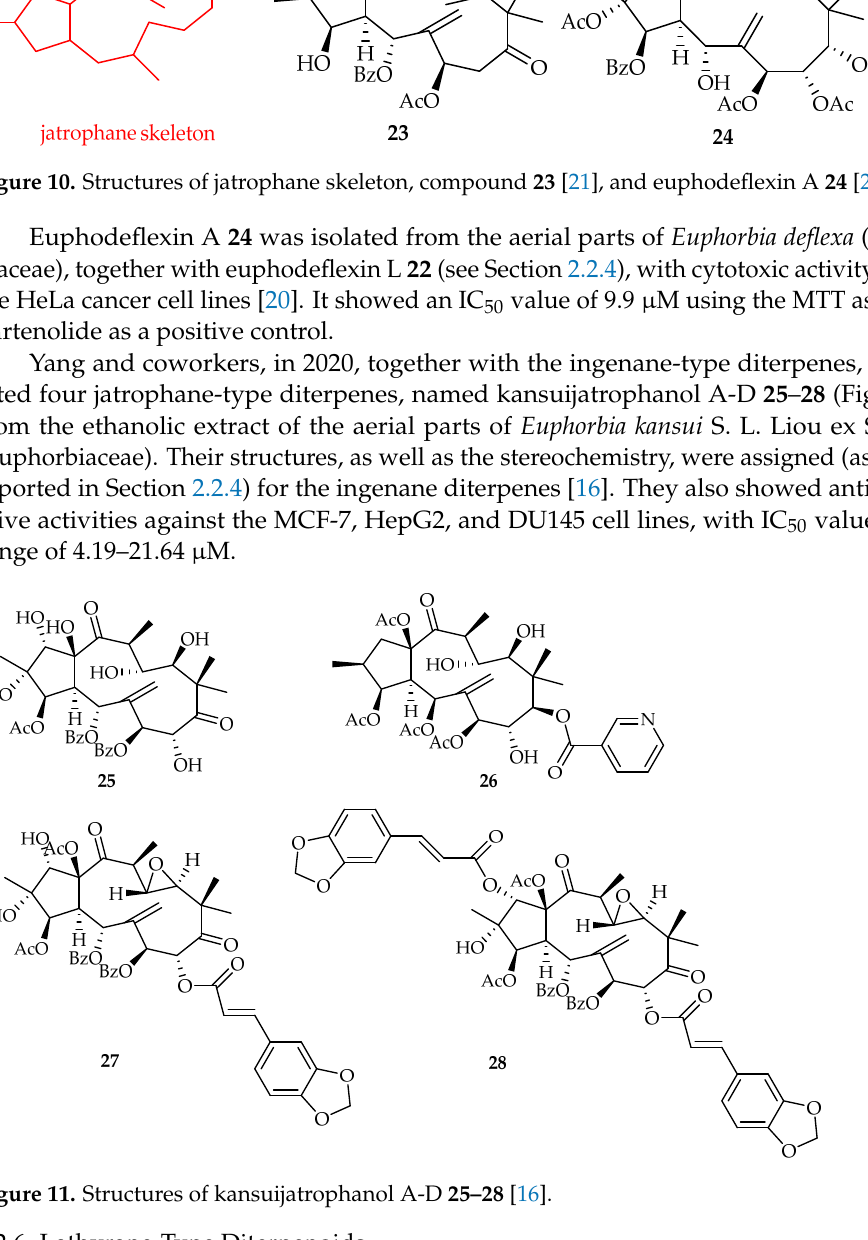
Figure 11. Structures of kansuijatrophanol A-D 25–28 [16].